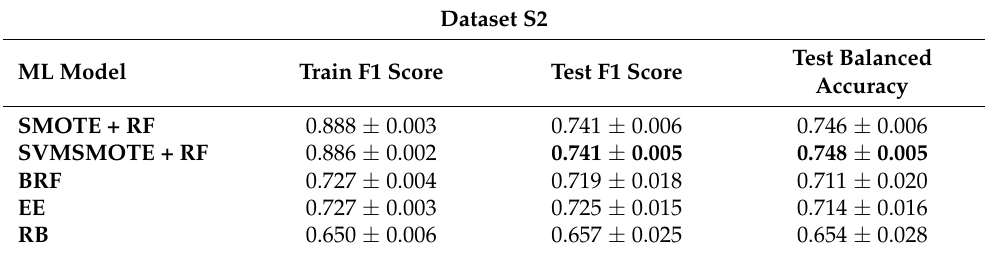
Table 5. Global evaluation metrics for each learning model built with the information at the end of second semester (dataset S2). Values represent mean and standard